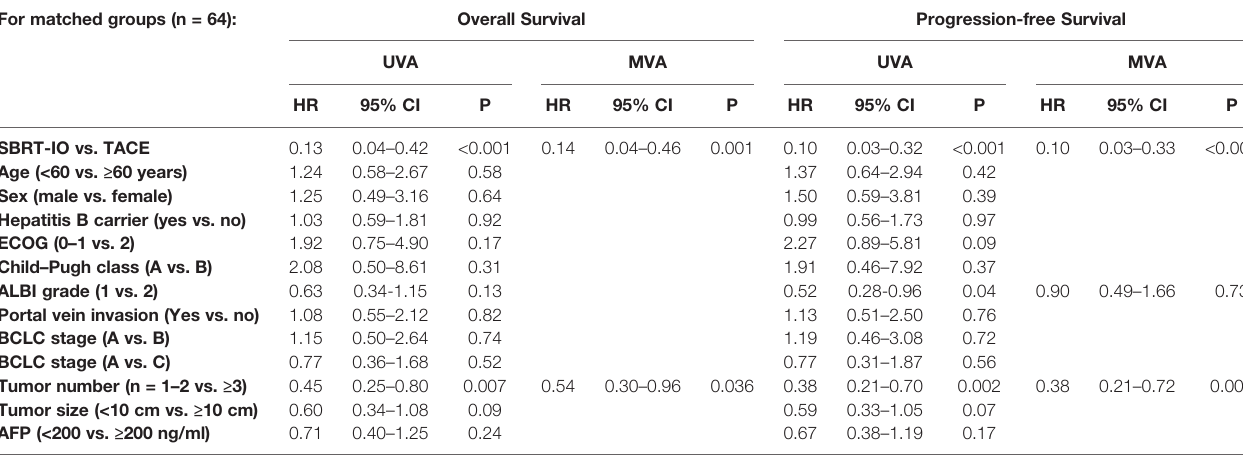
TABLE 2 | Univariate and multivariate analyses of potential prognostic factors affecting overall and progression-free survival after propensity score matching. For matched groups (n = 64):